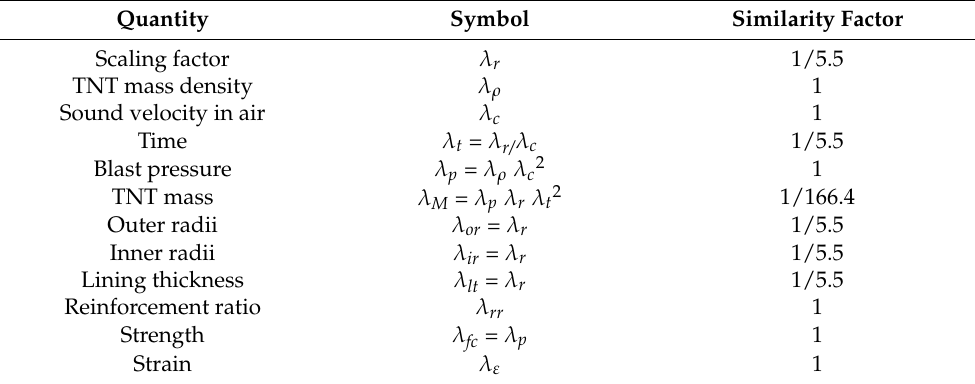
Table 1. Similarity ratio for the scaled blast